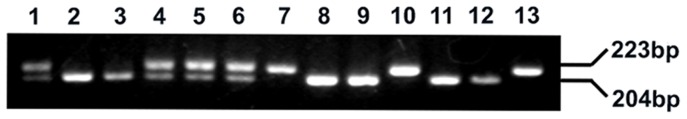
LAPTM4B genotyping. Analysis by separation with 2% agarose gel electrophoresis.Lanes 1, 4, 5, 6: genotype*1/2; lanes 2, 3, 8, 9, 11, 12: genotype*1/1; lanes 7, 10, 13: genotype *2/2.